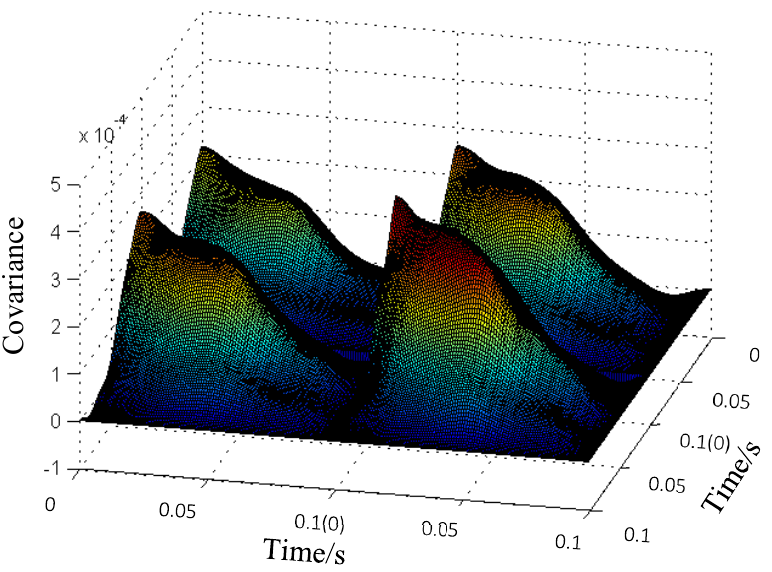
Figure 9. Covariance matrix of the measured responses.